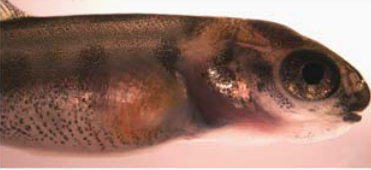
Figure 2. Atlantic salmon larva reared in an elementary classroom as part of a restoration project in Massachusetts. (Photo: Haruka